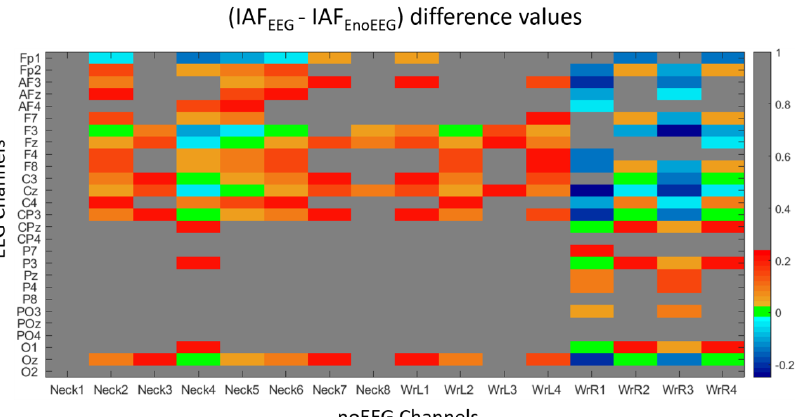
Figure 3. Values coming from the differences between cerebral (IAF EEG ) and non-cerebral (IAF noEEG ) IAF estimations. Red colors indicate the IAF EEG estimations were higher than the IAF noEEG estimations, while blue colors when the IAF EEG estimations were lower than the IAF noEEG estimations. On the contrary, green colors mean no difference existed, and differences higher than 0.25 were colored in grey.